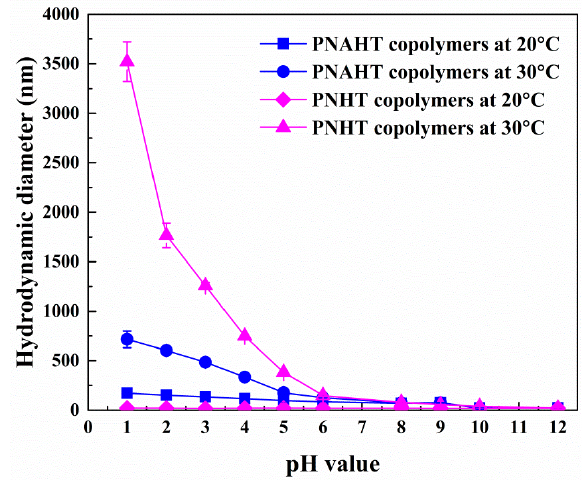
Figure 6. Changes in D AH of PNAHT and PNHT copolymers as plotted with pH value at 20 and 30 °C.